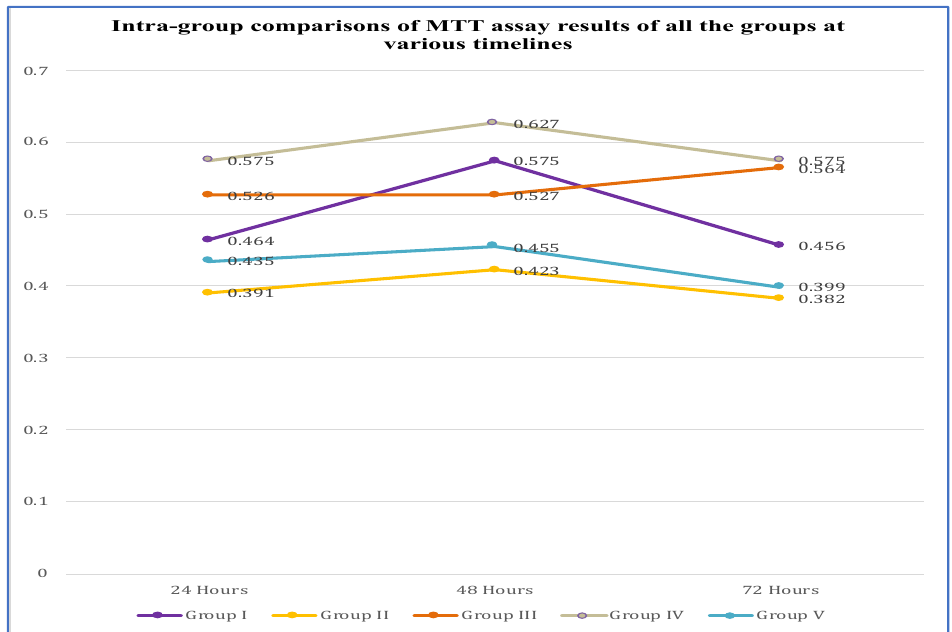
Figure 4. Intra group comparison of MTT assay results.